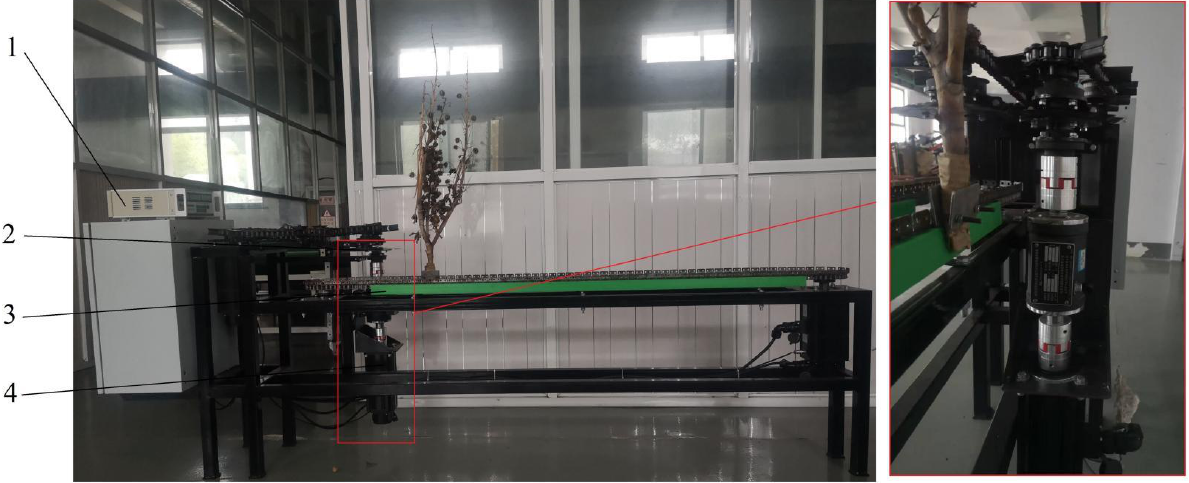
Figure 4. Castor disc-cutting device. (1) Measuring and controlling system. (2) Cutting system. (3) Feeding system. (4) Power